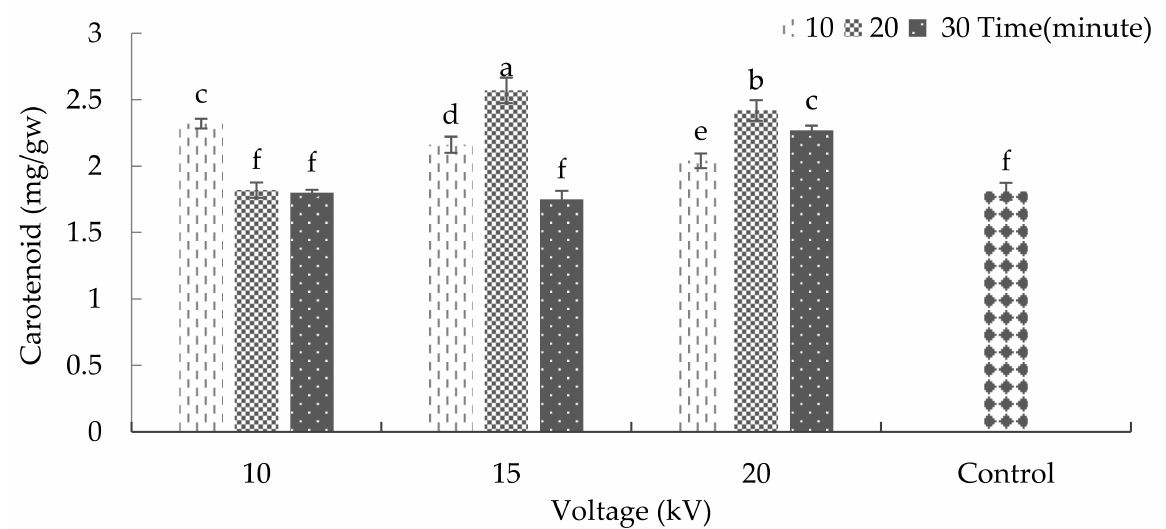
Figure 6. The effects of plasma on the carotenoid of basil. Error bars indicate standard error ( n = 3). Different lowercase letters denote statistical differences between treatment groups at the 5% level according to Duncan’s